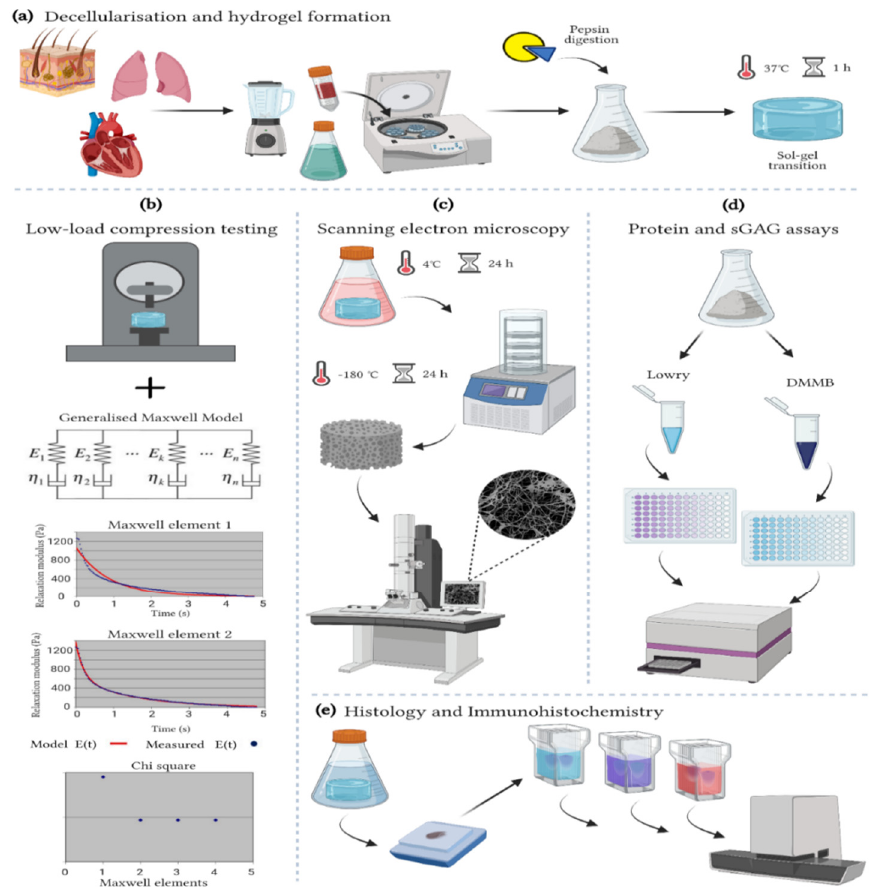
Figure 1. Methods. ( a ) Decellularization and hydrogel formation of skin-ECM, lung-ECM and LV- ECM ( b ) Low-load compression testing at 20% strain for 100 s. The data analyzed with a generalized Maxwell model of viscoelasticity. The number of Maxwell elements were determined based on curve- fitting the stress relaxation data (Relaxation modulus; Pa). The figure shows skin-ECM data, where two Maxwell elements were sufficient to explain their viscoelasticity, confirmed by the decrease in Chi 2 . ( c ) Scanning electron microscopy (SEM). All hydrogels were fixed for 24 h in 2% glutaraldehyde and 2% paraformaldehyde (1:1 ratio) at 4 ◦ C, freeze-dried for 24 h, metal coated and visualized with SEM. ( d ) Protein and sulphated glycosaminoglycans (sGAGs) quantification with Lowry